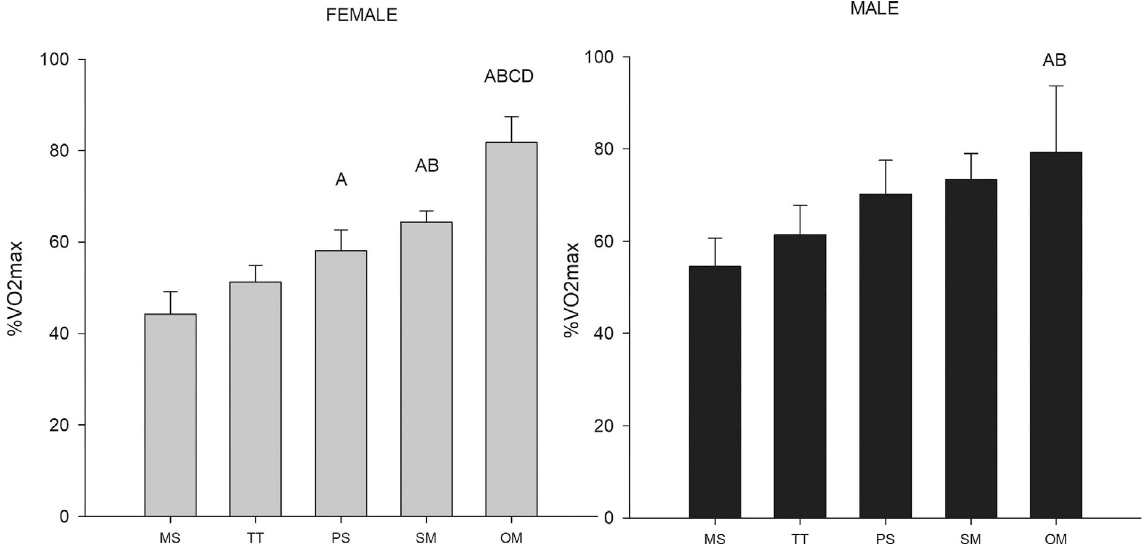
Figure 2 - %VO 2 max reached in the multi-shuttlecock, technical-tactical, physical, simulated match, and official match for the female and male athletes. A, significant difference compared to multi-shuttlecock; B, significant difference compared to technical-tactical; C, significant difference compared to physical; D, significant difference compared to simulated match (p <